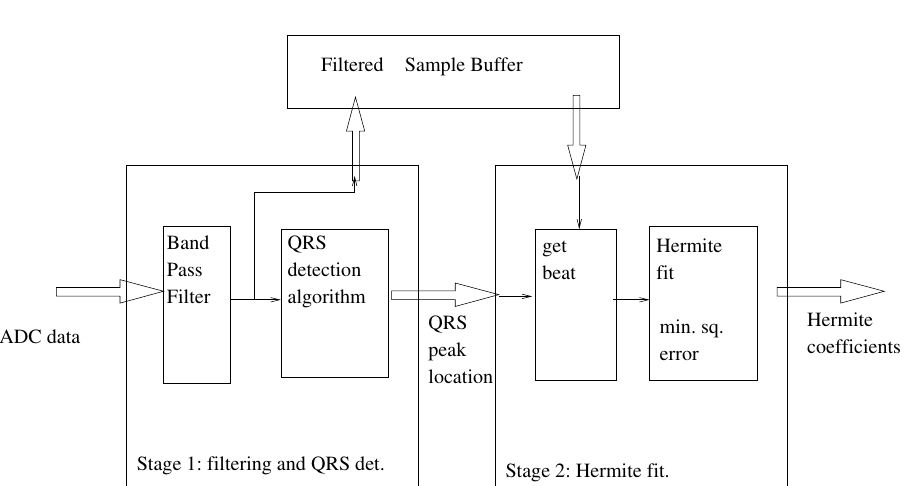
Figure 5. Detail of the two stages composing the